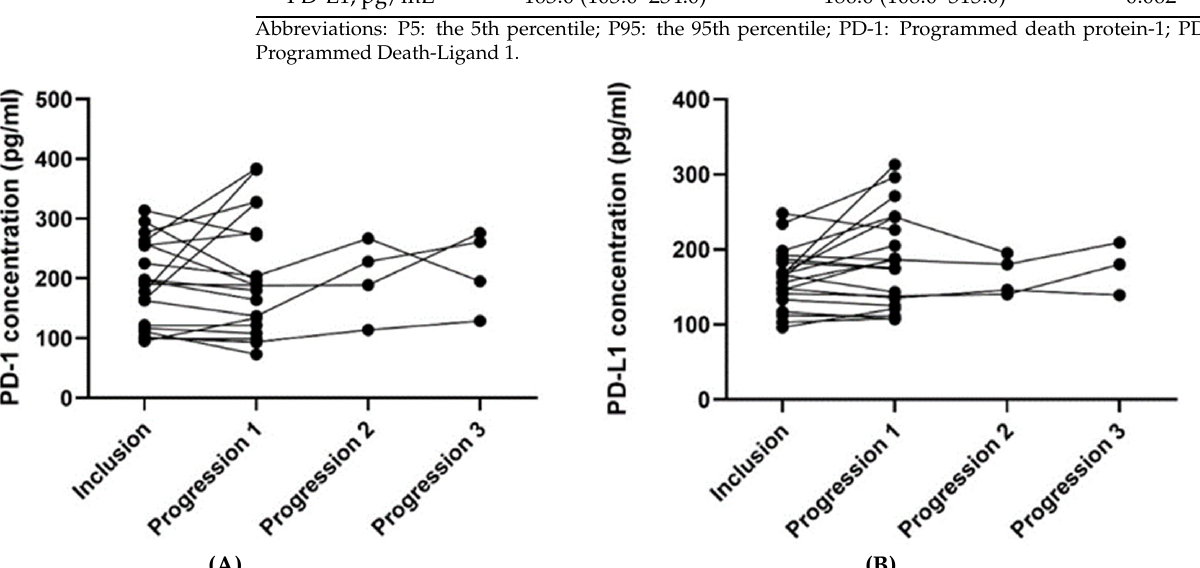
Figure 4. The plots visualize the PD-1 ( A ) and PD-L1 ( B ) concentrations at the time of inclusion and